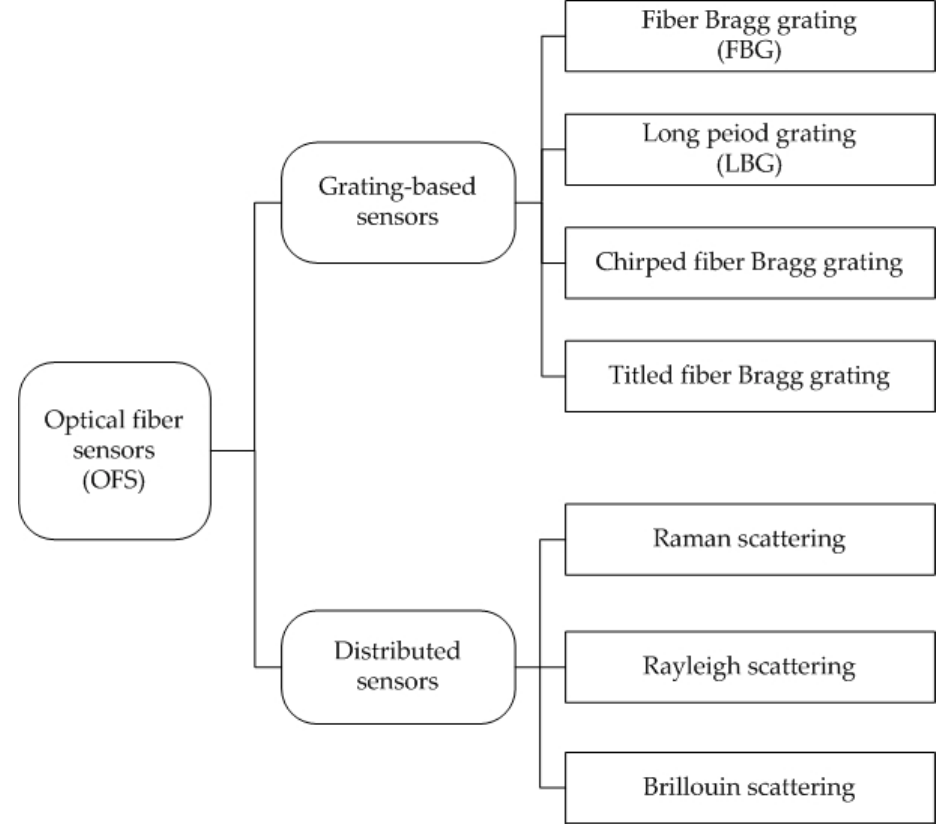
Figure 2. Classification of optical fiber strain sensors [15].